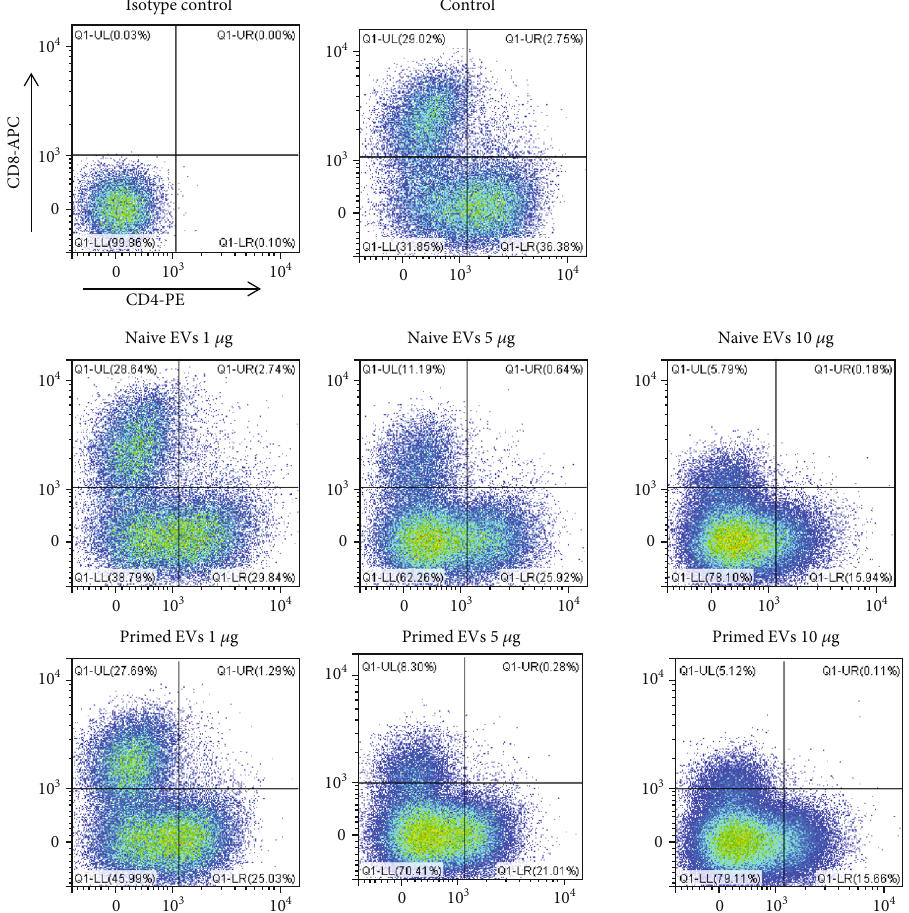
Figure 6: Immunophenotypic analysis of CD3, CD4, and CD8 in PBMCs cocultured with naive or primed cADSC-EVs at various concentrations (1, 5, and 10 μ